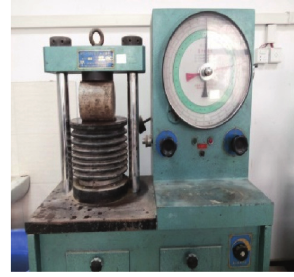
Figure 1: CBR test.